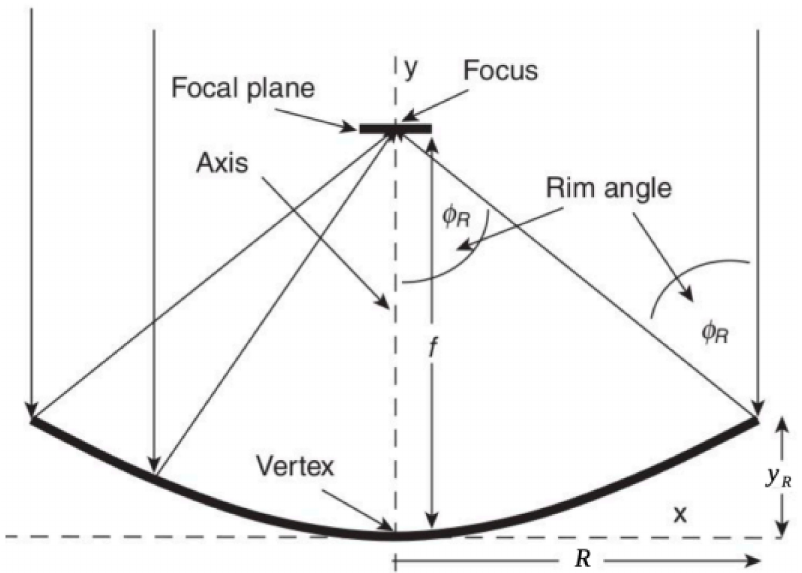
Figure 4. Geometry of a parabolic